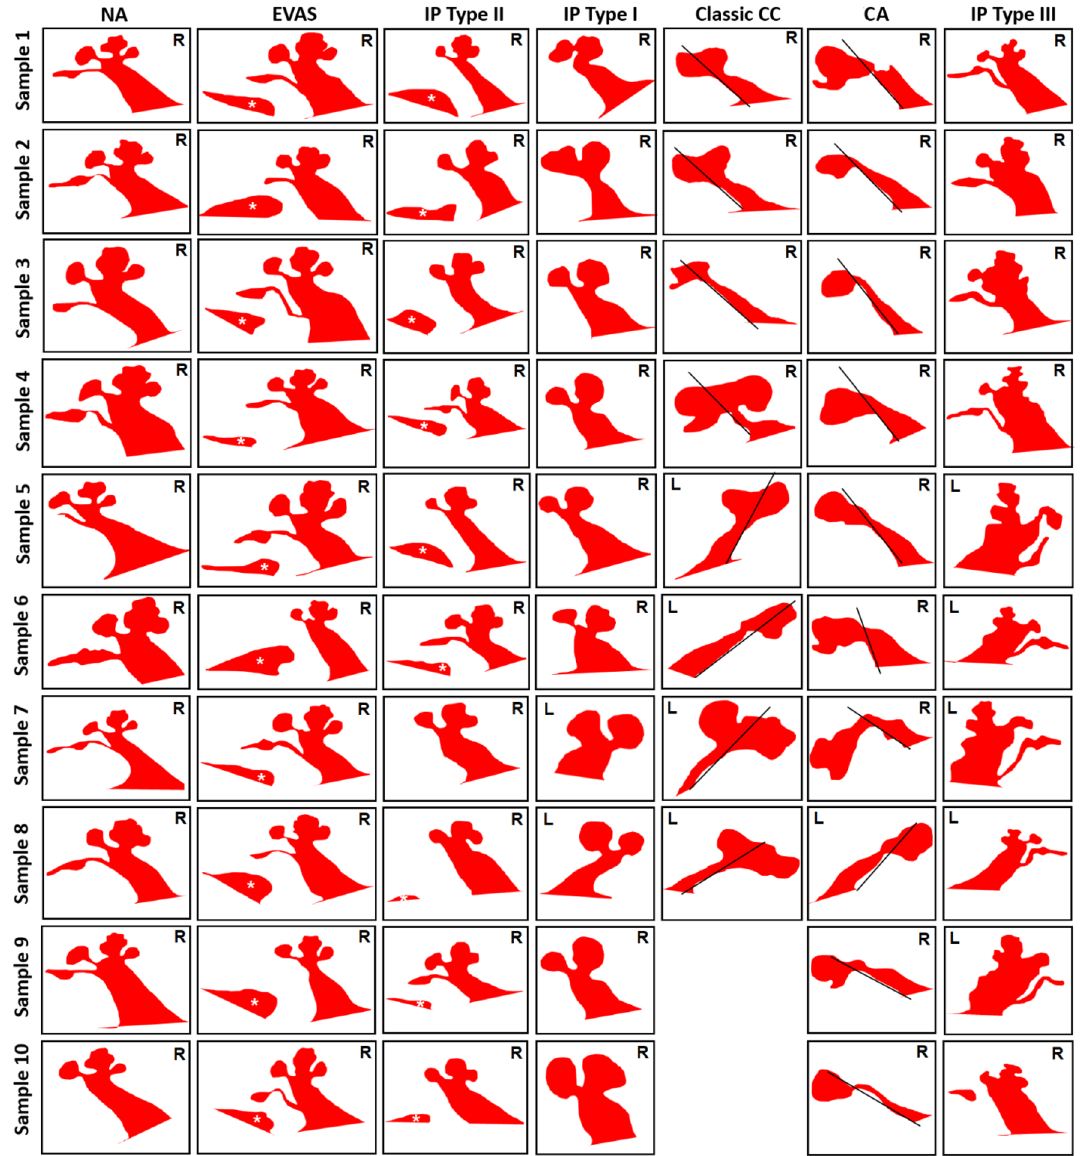
Figure 9. Atlas of outer contours of mid-modiolar section of inner ear of different anatomical types. Classic CC has eight samples whereas other inner ear malformation types have ten samples. White asterisk refers to the vestibular aqueduct and the black line separates the cochlear and the vestibular portion in classic common cavity (CC) and shows the presence of vestibular cavity in cochlear aplasia (CA) type malformations. The white asterisk points to the enlarged VA. Normal anatomy: NA, Enlarged vestibular aqueduct syndrome: EVAS, incomplete partition: (IP) type I, II and III, Cochlear hypoplasia: CH. Images are not to scale. R: right ear; L: left